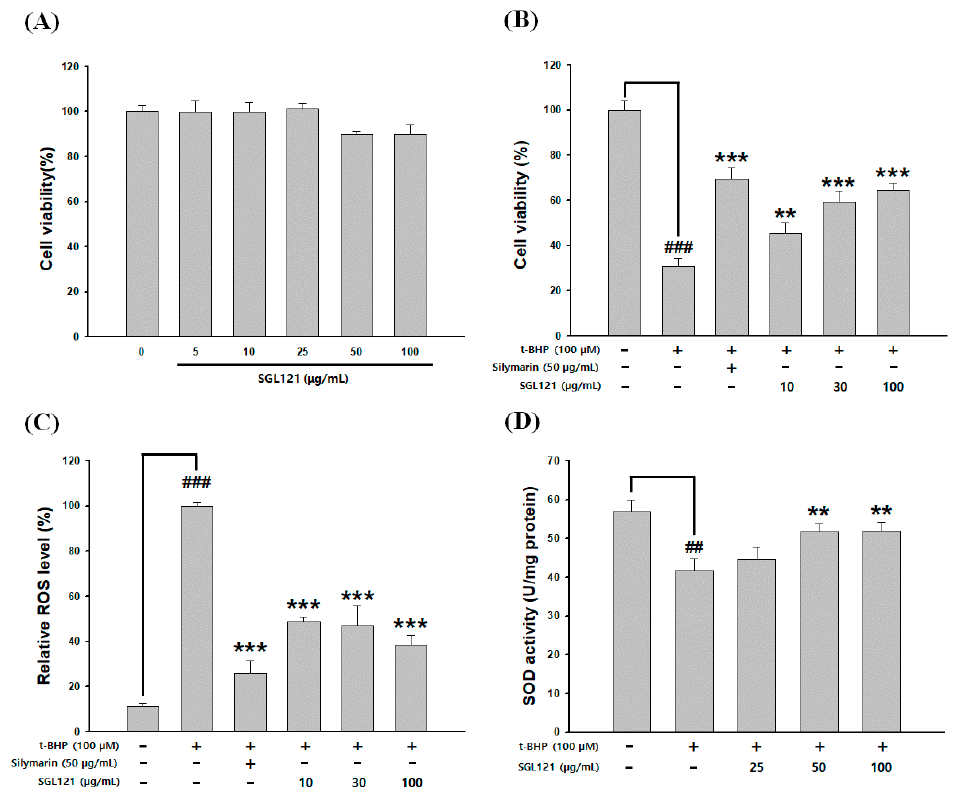
Figure 6. Effects of SGL 121 on tert-butyl hydroperoxide (t -BHP)-induced ( A ) cytotoxicity, ( B ) hepatotoxicity, ( C ) inhibition of reactive oxygen species (ROS) production, and ( D ) antioxidant enzymes. Data are presented as the mean ± SD. ## p < 0.01 and ### p < 0.001 compared to the